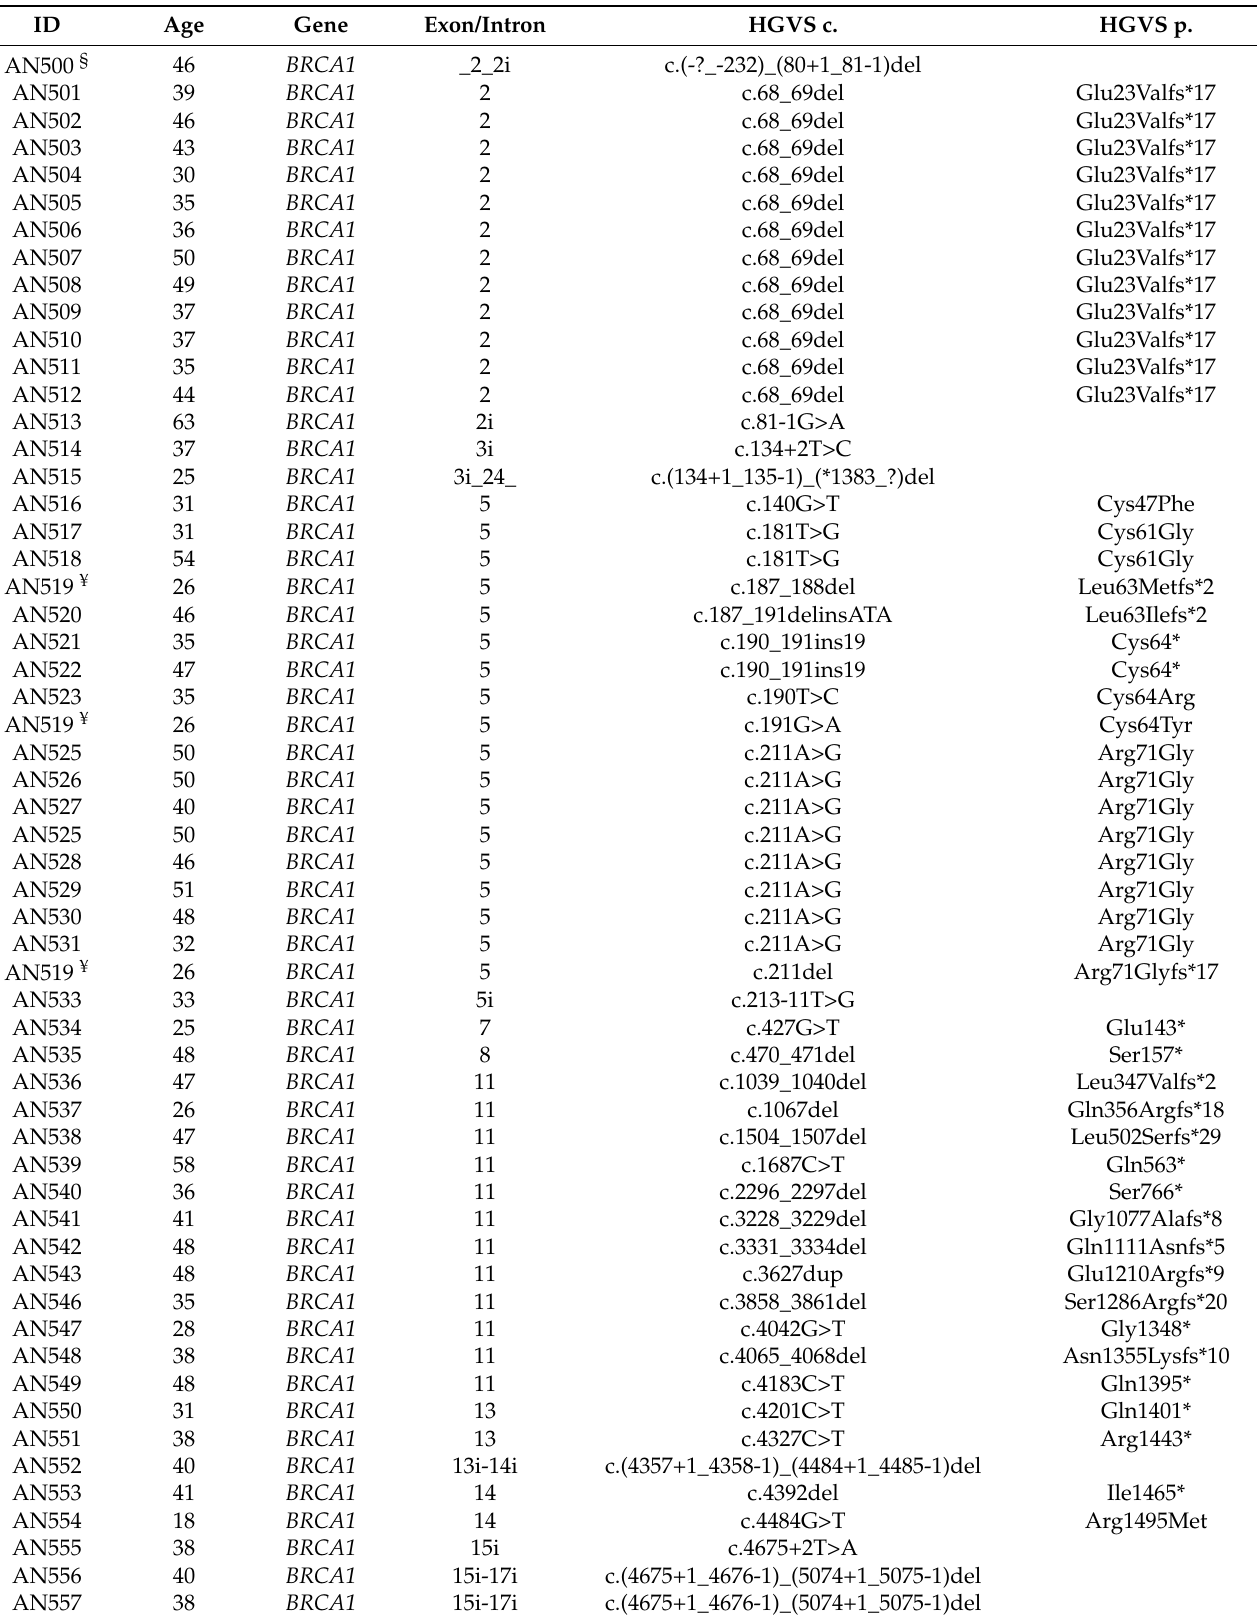
Table 4. Likely pathogenic/pathogenic variants detected in TNBC patients (n =